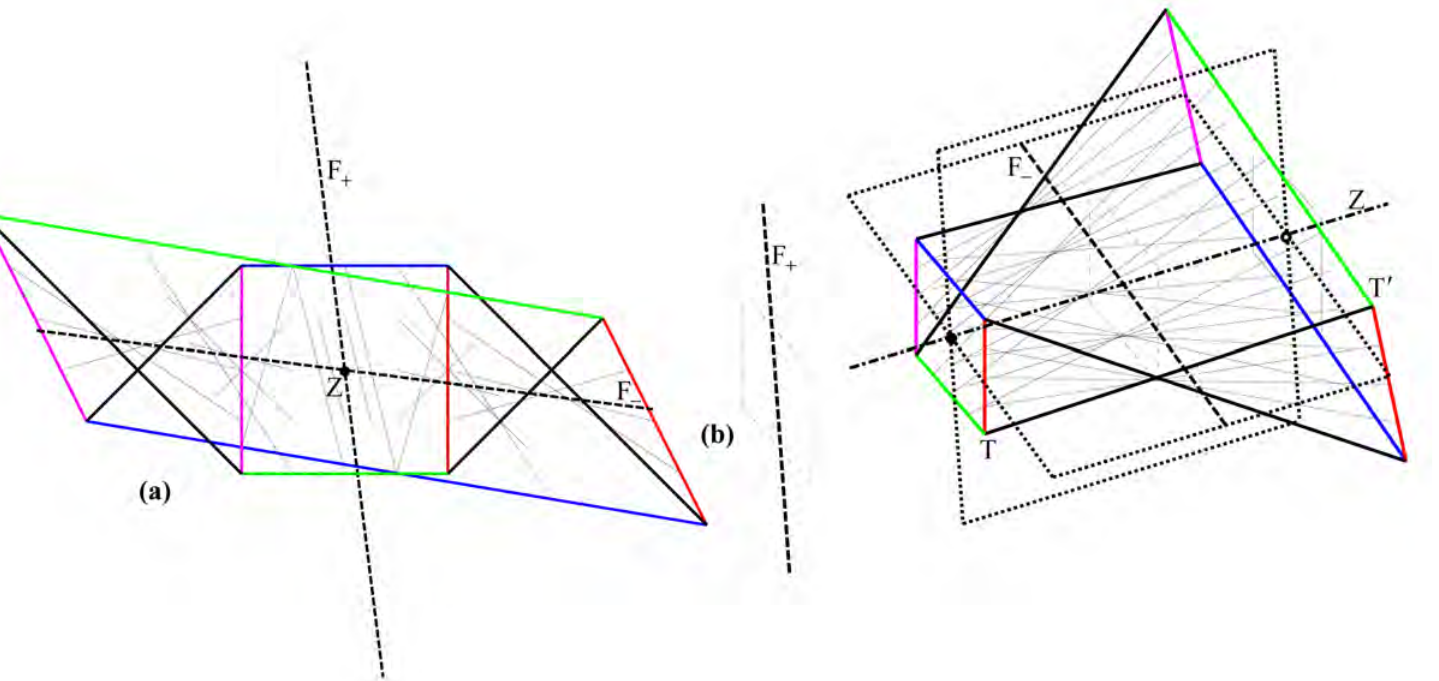
Figure 4 A pencil with divergency JM = D at T. The orthogonal pair of principal meridional planes is shown by means of dotted lines. Light dashed lines define the two focal planes. Heavy dashed lines represent the two orthogonal line foci + F and − F . One focal plane is upstream from entrance plane T. The rays diverge horizontally and converge vertically from T. The pencil is one possible in conventional astigmatic optical systems; the two focal planes define the interval of Sturm. (b) azimuth °− 64 27 °− 64 , eleva- tion 38 °− 64 .